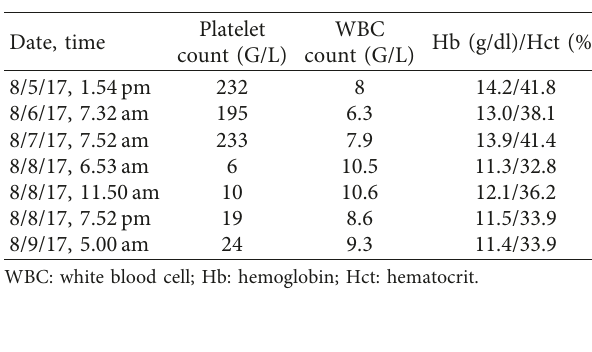
Table 1: Results of the automated complete blood count tests.